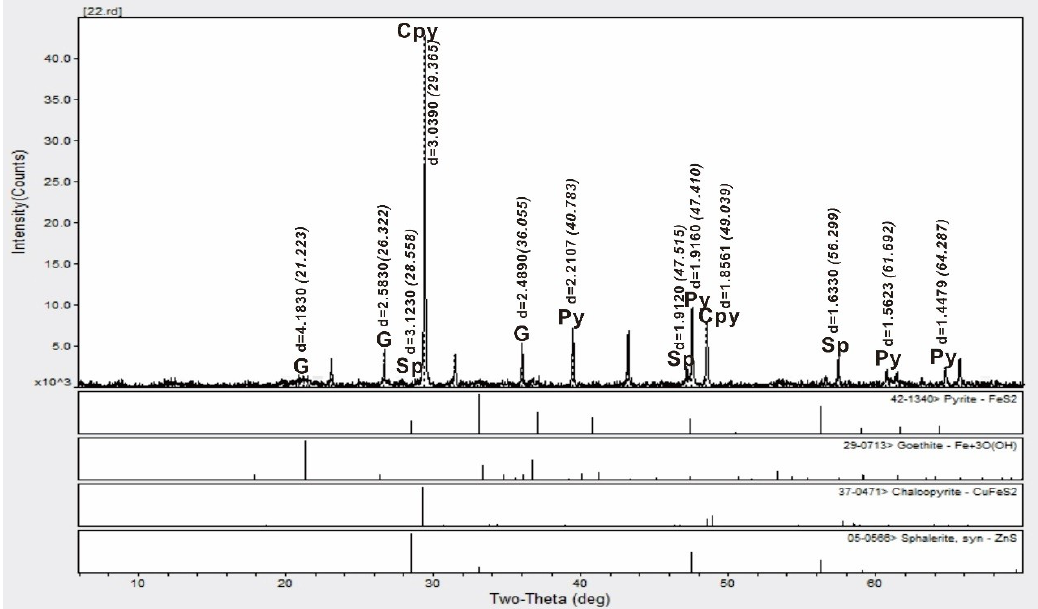
Figure A4. Bulk XRD patterns of representative samples of Wocan-2 (station 28I-TVG10); the 2θ values are enclosed in the brackets, whereas the first values are the d values. Characteristic peak values were compared with References [35,36]. Abbreviations G: Goethite; Sp: sphalerite; Cpy: chalcopyrite; Py: pyrite. Other XRD peaks on Wocan-2 sediment have been reported in Reference [37].